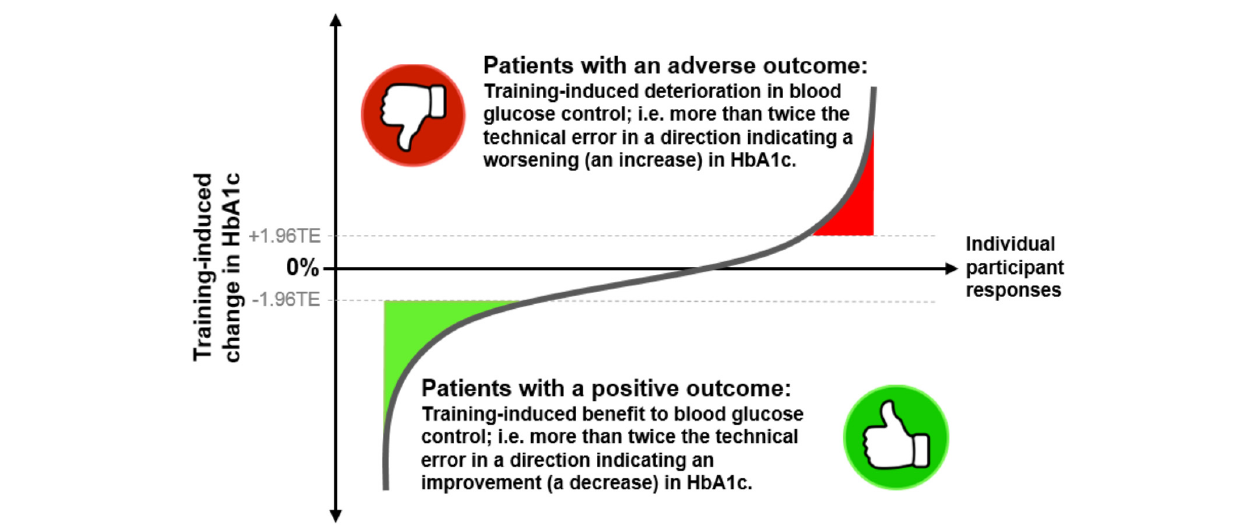
FIGURE 1 | A cartoon depicting the inter-individual variability of changes in HbA1c levels following exercise training in individuals with prediabetes or type 2 diabetes. The y -axis represents the training-induced change in HbA1c (post- minus pre-intervention value). The x -axis represents the individual participants taking part in a study. Adverse outcomes are illustrated as participants’ responses showing a training-induced increase in HbA1c that is more than 1.96 times the technical error (TE). Therapeutic outcomes are shown as training-induced decreases in HbA1c that are greater than 1.96 times the technical